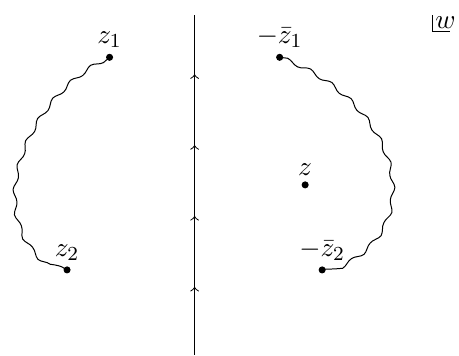
Figure 10 . The contour of integration in eq. (4.13) runs on the imaginary axis and is marked by arrows. The position of the singularities of the integrand refers to a Euclidean con(cid:12)guration. long as we are careful to deform the contour of integration such that z and (cid:0) (cid:22) z ; (cid:0) (cid:22) z ; z lie on the right. Hence, we can study the nature of the singularities as z 1 2 collides with other insertions without performing the integral. There are no singularities as z ! (cid:22) z , as expected. On the contrary, there are branch cuts originating from z = z i z = z , which correspond to u = 1 and u = 1 in (cid:12)gure 9. Indeed, when we move z to the 2 region on the left of the contour, we pick up the contribution of the pole at w = z in the second line of eq.